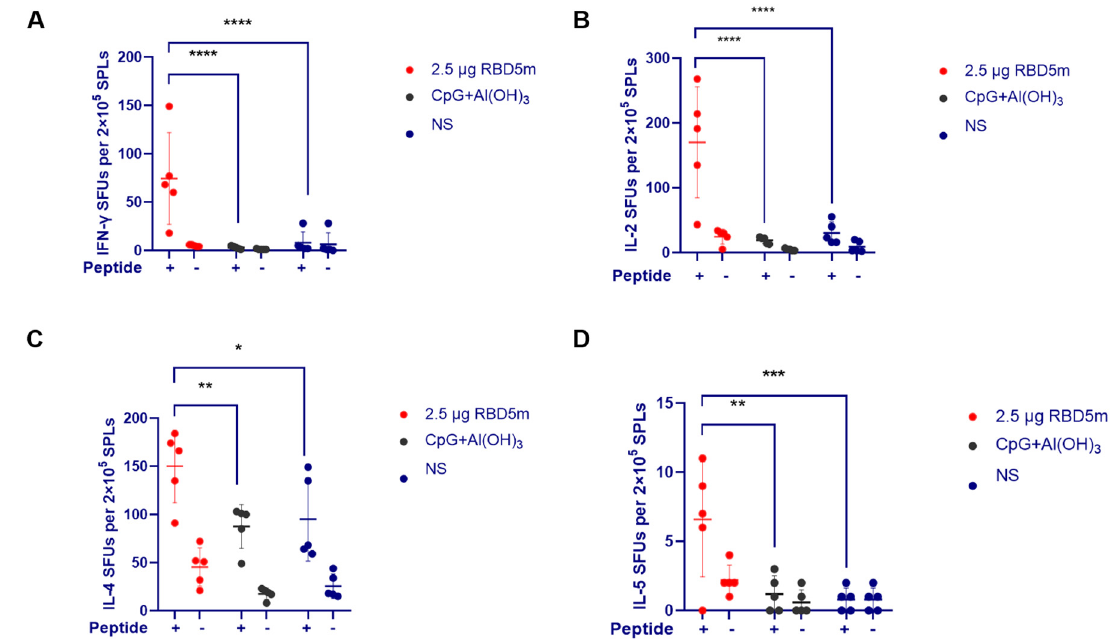
Figure 5. RBD5m immunization elicits a T cell response in BALB/c mice. ( A – D ) IFN- γ ( A ), IL-2 ( B ), IL-4 ( C ), and IL-5 ( D ) expression was detected in mouse splenocytes by ELISpot trials. The “+” sign indicates that mouse splenocytes were stimulated by the addition of the full-length peptide for SARS-CoV-2 S protein. The data were collected on an ELISpot board reader. ns: no significant difference; * p < 0.05; ** p < 0.01; *** p < 0.001; **** p <